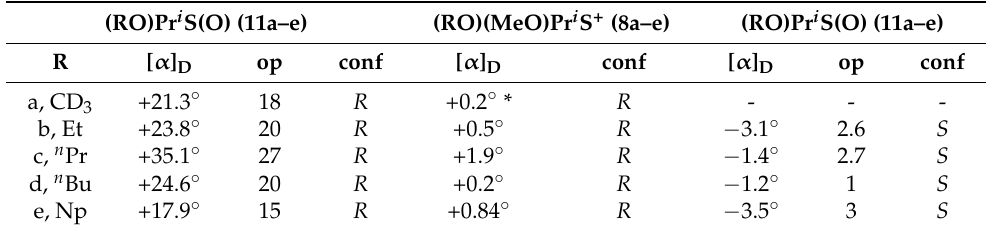
Table 1. Selected data on alkyl sulfinates 11 , dialkoxysulfonium salts 8 and sulfinates 11 formed after alkaline hydrolysis of 8 .